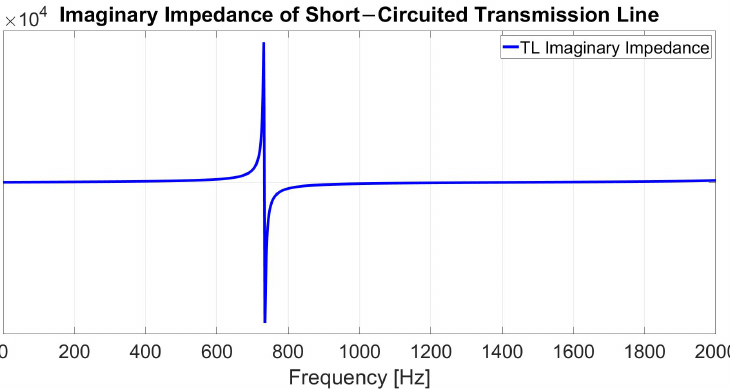
Figure 5. Frequency response measurements of a single phase transmission line imagi- nary impedance.